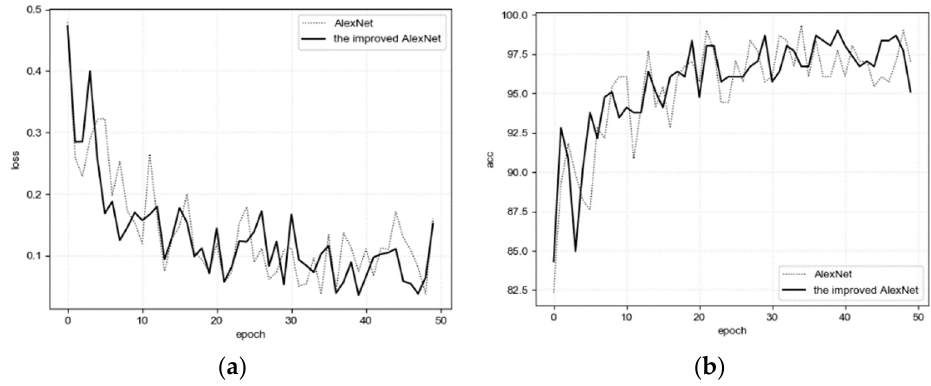
Figure 12. Comparison results of AlexNet and optimized AlexNet. ( a ) loss; ( b ) acc.